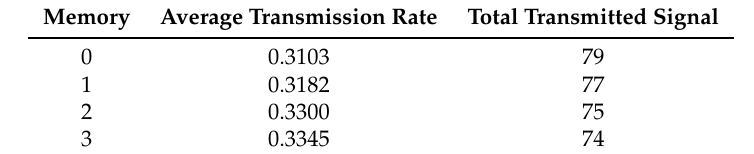
Table 2. The average transmission rate and total transmitted signals for each memory number.